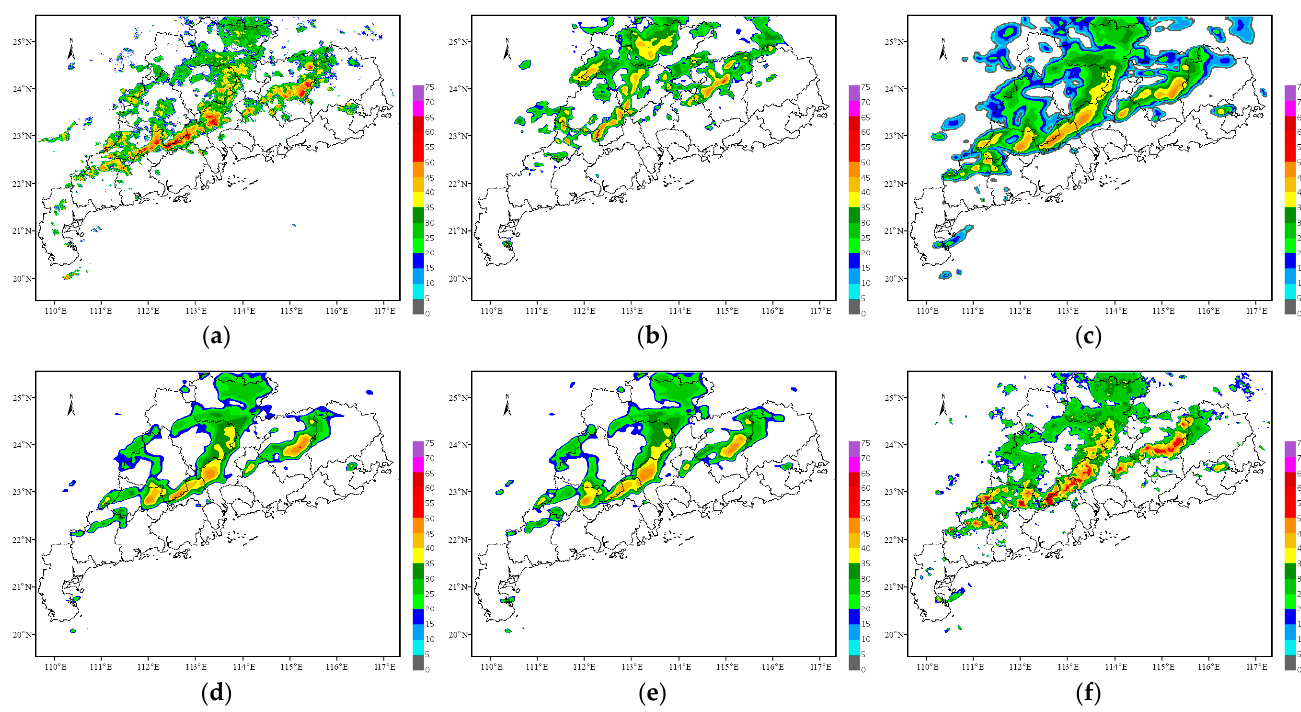
Figure 4. Nowcasting results of the squall line process for the next 0.5 h. ( a ) Observation; ( b ) Opti- calflow; ( c ) ConvGRU; ( d ) PredRNN; ( e ) PredRNN V2; ( f ) TSGAN.